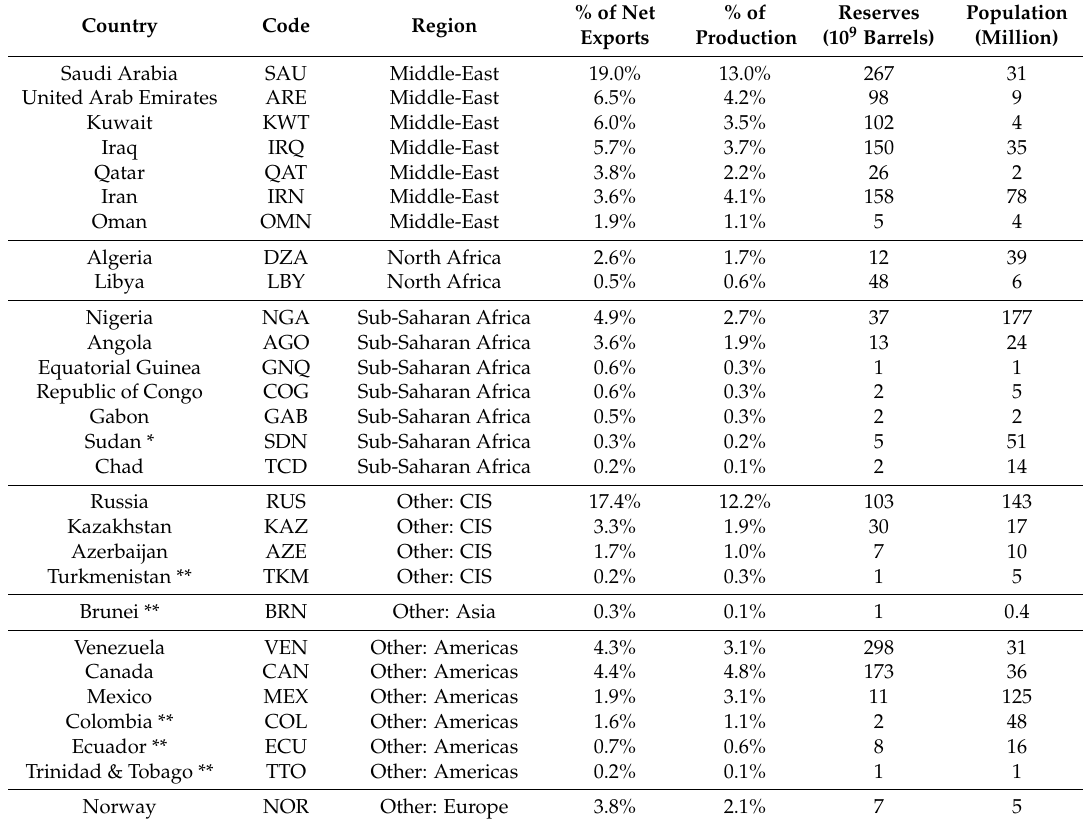
Table 1. Descriptive statistics for oil-exporting countries (2014). Data source: Oil production and consumption [19,20]; population [21]. Abbreviations: Commonwealth of Independent States (CIS).